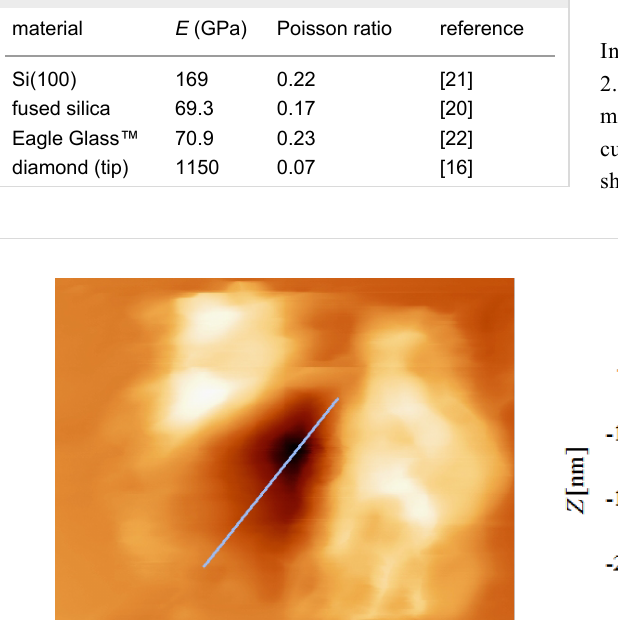
Table 2: Reported properties of the materials used in nanoindentation